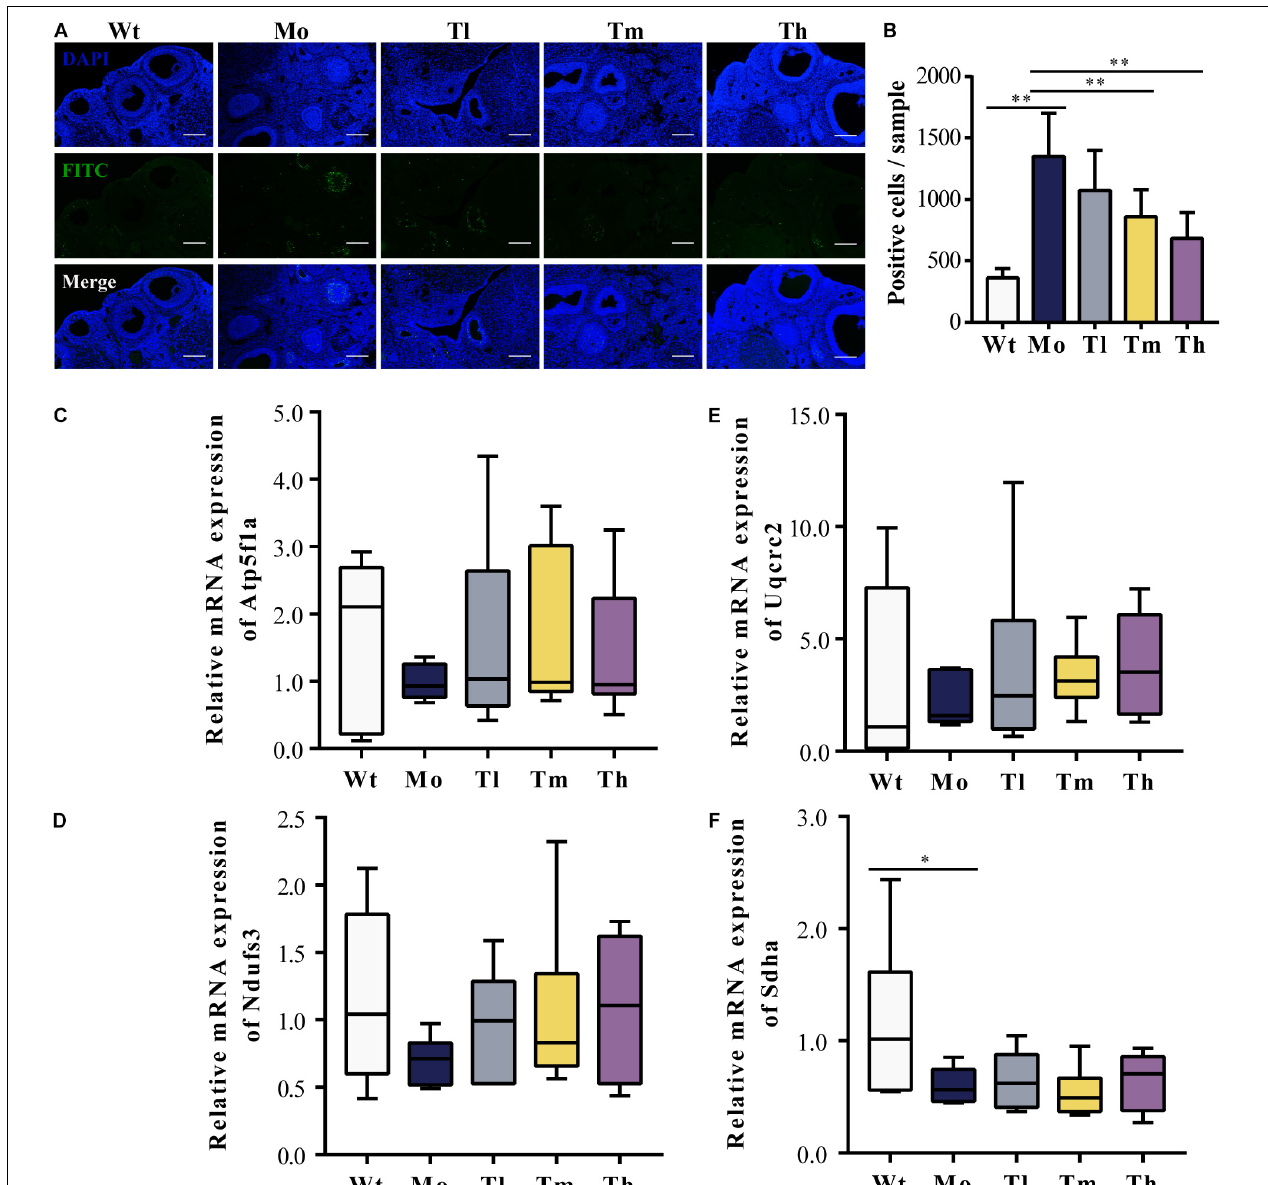
FIGURE 2 | Improvement of the ovarian microenvironment after rhGH administration. (A,B) TUNEL assay for evaluation of the apoptosis of ovarian cells. The nuclei were labeled with DAPI staining (blue) and fragmented DNA were stained with FITC-12-dUTP (green), quantified by counting the number of FITC-labeled